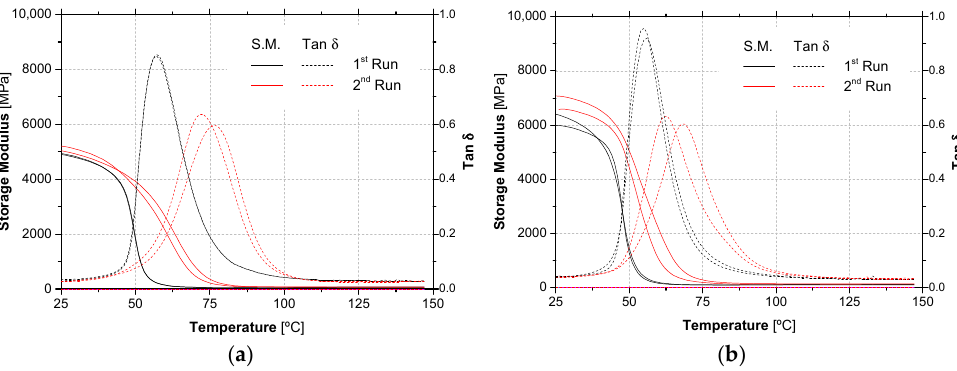
Figure 8. DMA experimental curves of unaged adhesives ( a ) ADH1 and ( b ) ADH2—in two con- secutive temperature runs.